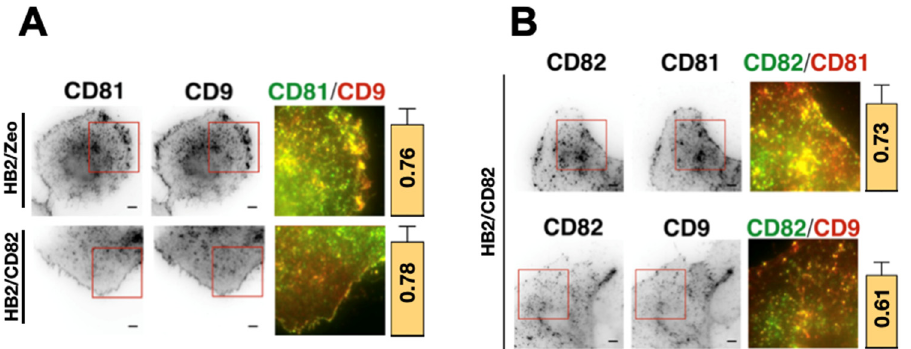
Figure 3. Ensemble labelling of CD9, CD81 and CD82 in HB2/Zeo and HB2/CD82 cells. ( A ) CD9-CD81 colocalization in both cell lines; ( B ) CD82-CD9 or CD81 in HB2/CD82 cells. The scale bar represents 5 µ m. Images on the right part of both panels correspond to zooms delineated by the red boxes and represent the merge of the two channels. The yellow pixels represent the colocalization between tetraspanins. The histograms represent the calculated Pearson’s correlation coefficients between the two signals in HB2/Zeo and HB2/CD82 cells using the «colocalizer studio» plugin of the open-source community image processing software Icy (Release 1.9.4.0). Calculations were done on at least 10 cells and the error bars represent the standard deviation.